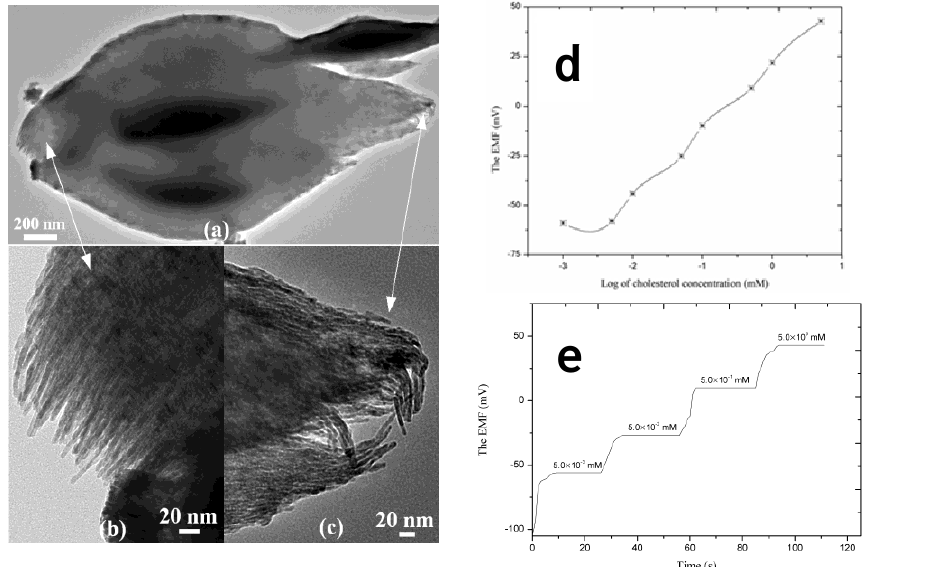
Figure 10. ( a – c ) TEM images of nanowire bundles; ( d ) calibration curve of cholesterol biosensor with detection limit; and ( e ) response time of the cholesterol biosensor in the different cholesterol concentrations